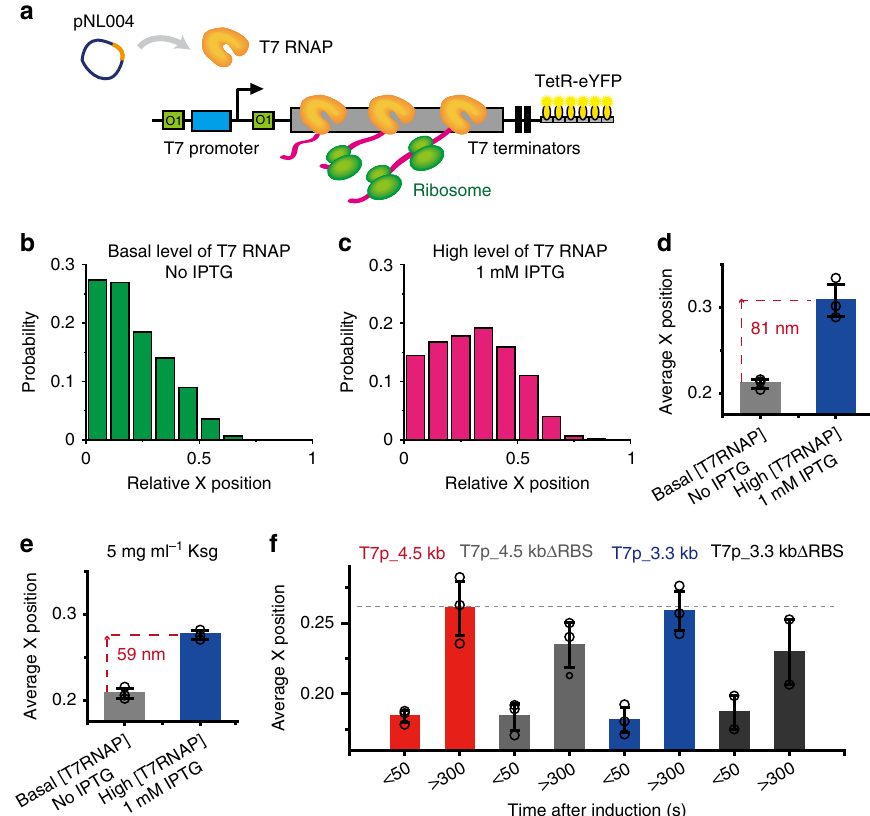
Fig. 5 Effects of transcriptional activity and ribosome binding to mRNA on gene locus movement. a Schematic of the gene system used to detect the location of the lacZ gene transcribed by wild-type T7 RNAP. Twelve repeats of TetO were inserted downstream of tandem T7 terminators. TetR-eYFP bound to the TetO array was detected as a fl uorescent spot. T7 RNAP was expressed from an L-rhamnose inducible plasmid (pNL004). b , c Distributions of the subcellular localization of a gene locus transcribed by T7 RNAP. b The distribution of the gene locus with a basal level of T7 RNAP (no rhamnose) and no IPTG. c The distribution of the gene locus when T7 RNAP was expressed by the addition of 0.2% L -rhamnose and 1 mM IPTG. d Comparison of gene locus movement. Average relative x-positions of the gene loci from Fig. 5b (gray bar, basal level of T7 RNAP and no IPTG) and Fig. 5c (blue bar, high expression of T7 RNAP and 1 mM IPTG). e Comparison of gene locus movement under translation initiation inhibition conditions. The same experiment was performed as shown in Fig. 5d after a 15-min incubation with 5 mg mL − 1 kasugamycin (Ksg), which inhibits translation initiation. f Comparison of gene loci movement with and without the RBS. Red and blue bars denote the average relative x-positions of lacZ gene loci of T7p_4.5kb and T7p_3.3 kb, respectively, within each time window. When the RBS was deleted, gene locus movement was reduced by ~30% (gray bars: T7p_4.5kb Δ RBS and dark gray bars: T7p_3.3kb Δ RBS). Bar and error bars represent mean ± s.d. from three independent experiments. Each point represents independent